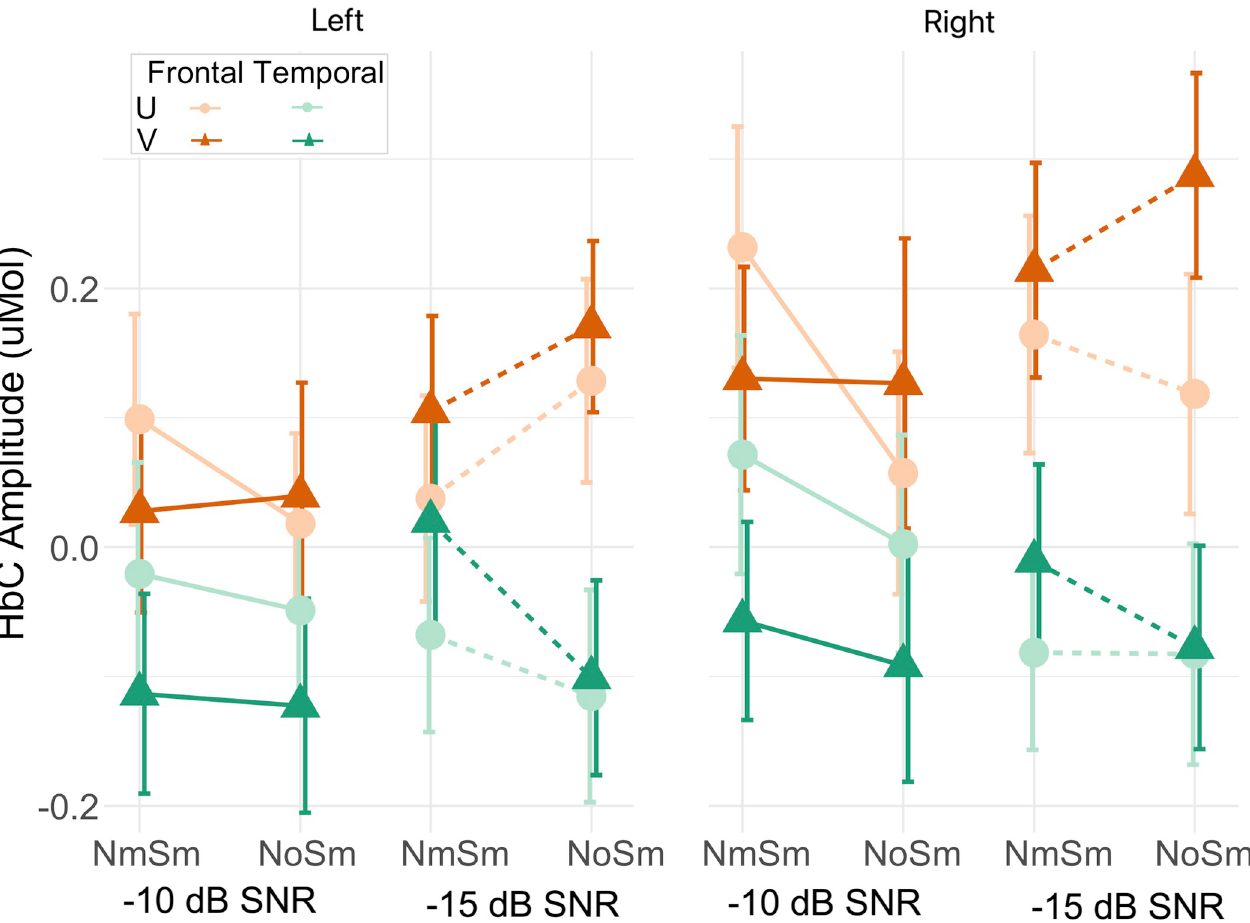
Fig 5. Δ HbC amplitudes in the frontal and temporal cortex. Group mean Δ HbC amplitudes for the frontal (orange) and temporal (green) cortex on the left and right hemispheres in response to unprocessed (dots) and vocoded speech (triangles) at -10 dB (solid lines) and -15 dB SNR (dash lines) are plotted.